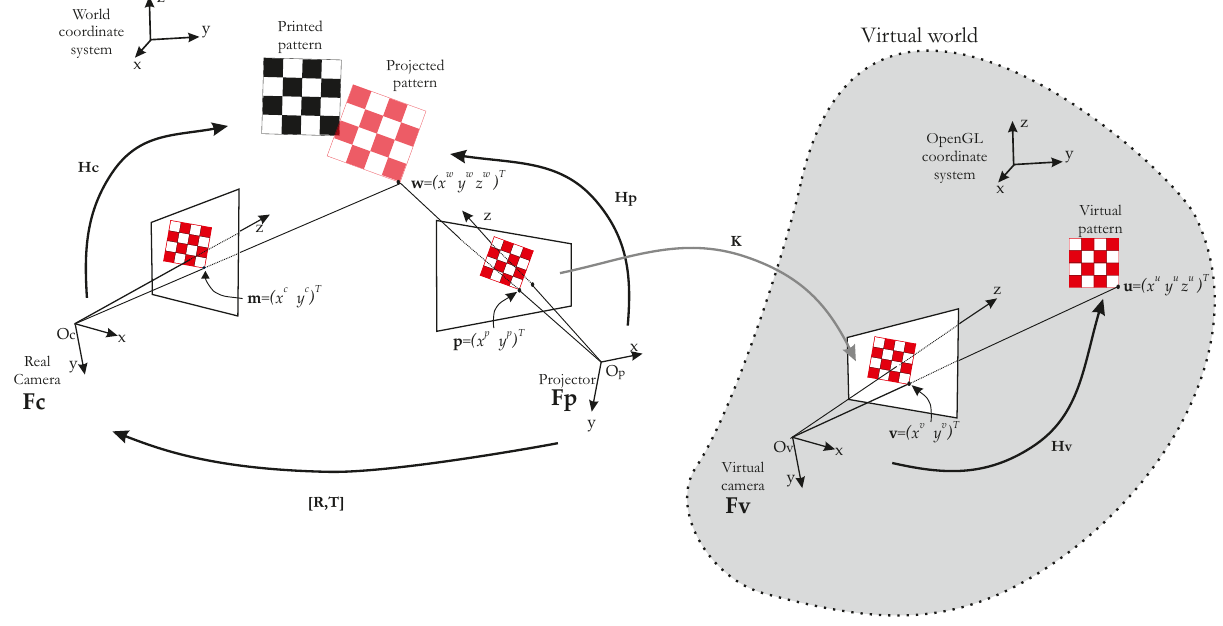
Figure 5. System model: The model consists of three frames representing each device. F the “real” camera frame. This is the camera of the stereo rig-like system. F frame, and Fv is the “Virtual” camera or OpenGL camera. The sole transformation between F and F is their image planes. In other terms, the image plane of F p v image plane of F via the graphic p